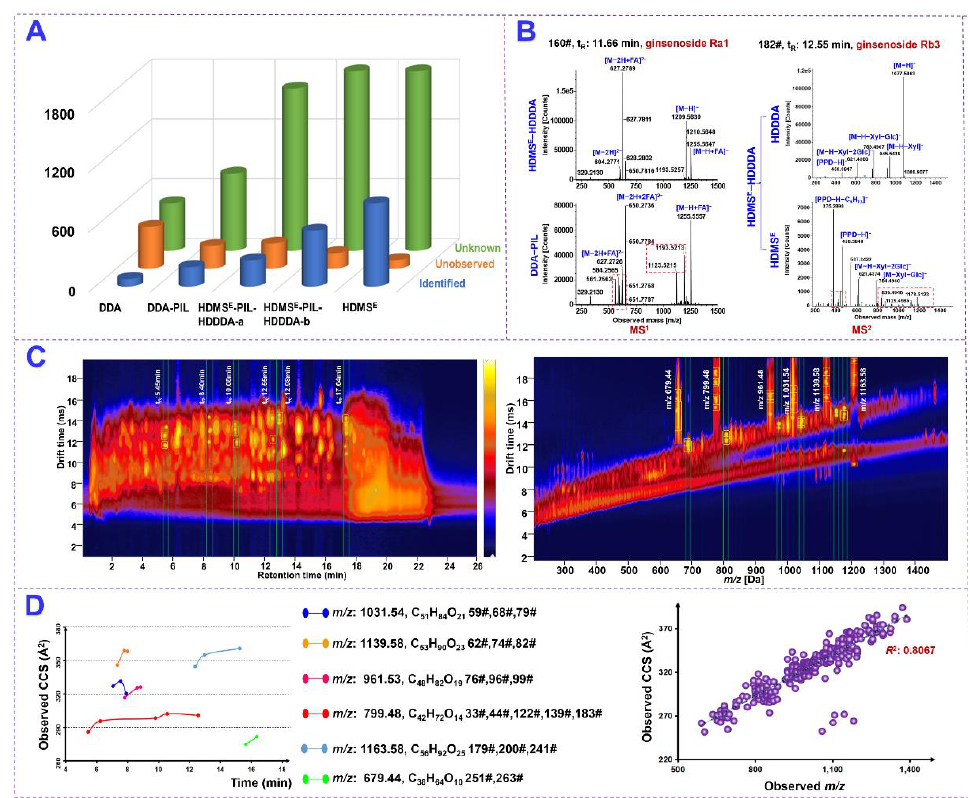
Figure 3. Superiority demonstration for the developed hybrid scan approach of HDMS E - PIL/HDDDA in the characterization of ginsenosides from PGL, PQL, and PNL. ( A ): A three-dimen- sional histogram showing the numbers of “ Identified Components ”, “ Unobserved Components ” , and “ Unknown Components ” acquired from the QC1 sample by four different scan approaches; ( B ): Comparing the MS 1 spectra acquired by the hybrid scan approach and DDA-PIL (showing the better resolution facilitated by enabling IM separation) and the MS 2 spectra obtained by HDMS E and HDDDA of the hybrid scan approach (showing better spectra quality for DDA); ( C ): 2D heat maps of drift time VS t R (showing the separation for 6 groups of co-eluting components) and drift time VS m/z (showing the separation for 6 groups of isomers); ( D ): the CCS distribution for 6 groups of iso- mers and the 2D scatter plot (CCS VS m/z ) for the 342 components characterized from PGL, PQL, and PNL.